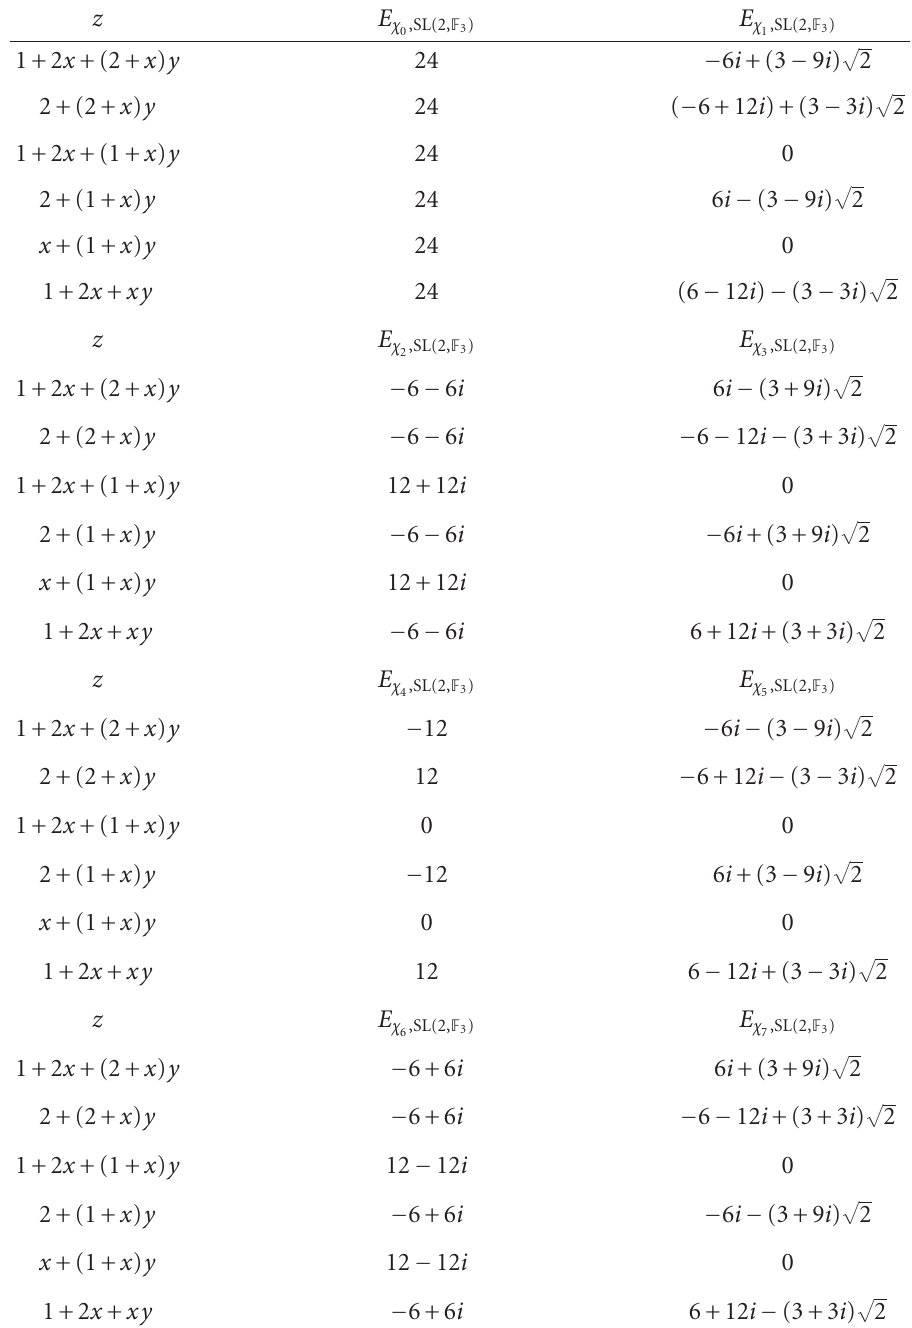
on SL(2, F 3 ) \ H 9 for χ = χ a , 0 ≤ a ≤ 3 )